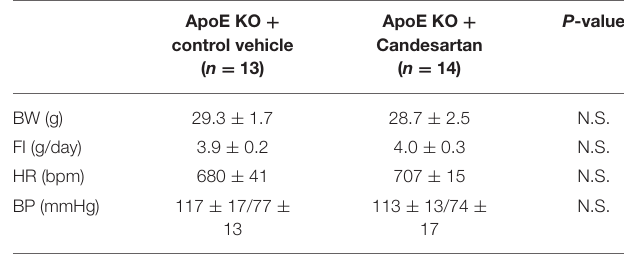
TABLE 3 | Body weight, food intake, heart rate, and blood pressure of ApoE KO mice administered with Candesartan or the control